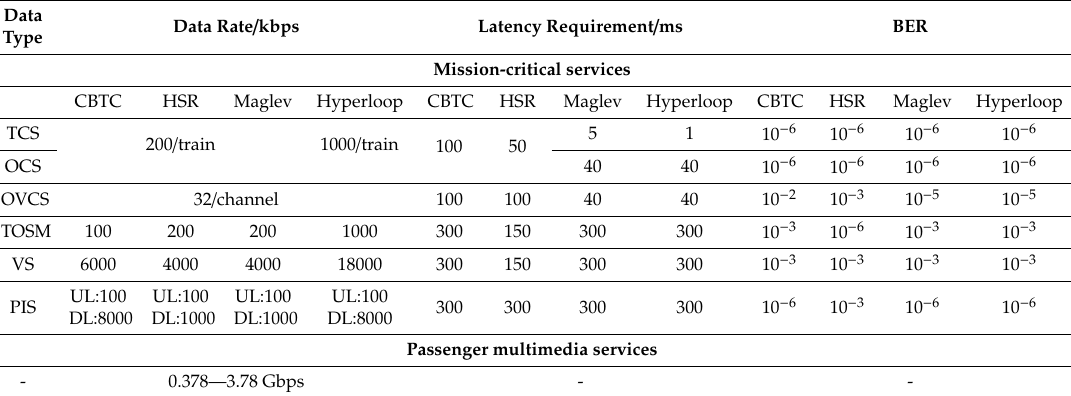
Table 2. Key KPIs of train-to-ground communication services